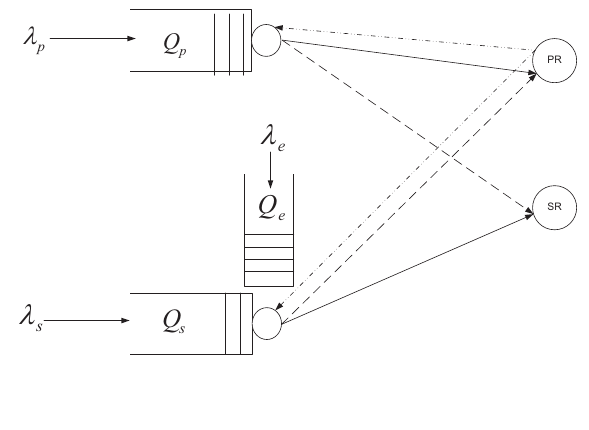
Figure 1. Primary and secondary queues and links. The PU has data queue Q p , whereas the secondary terminal has data queue Q s and energy queue Q e . There is a feedback channel between the primary receiver (PR) and the PU to acknowledge the reception of data packets. This feedback channel is overheard by the secondary transmitter. Both the PR and the secondary receiver (SR) may suffer interference from the other